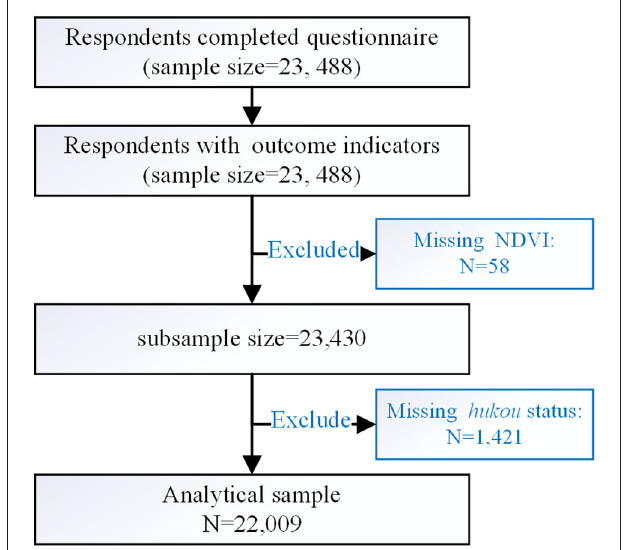
FIGURE 3 | Flowchart for participant